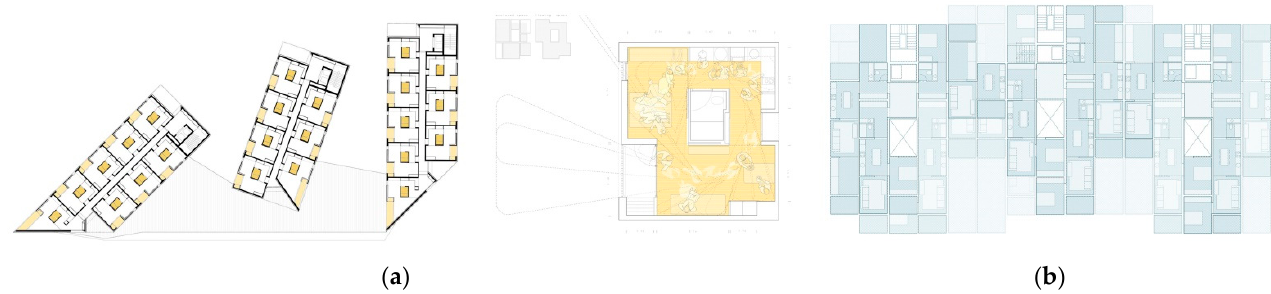
Figure 2. Mixed-use housing complex for elderly people in Barcelona ( a ) and social housing complex in Ibiza, Spain ( b ). Drawings: Peris + Toral Arquitectes.